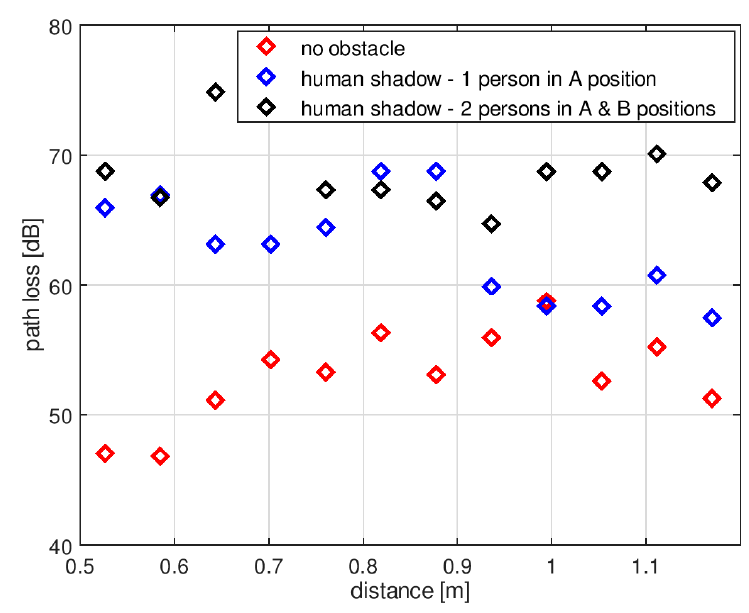
Figure 14. Results of path loss measurements in the indoor environment—first scenario.